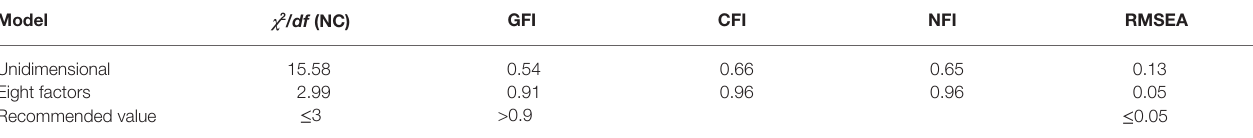
TABLE 3 | Goodness-of-fit indices from confirmatory factor analysis (Sample B; N = 909). Model